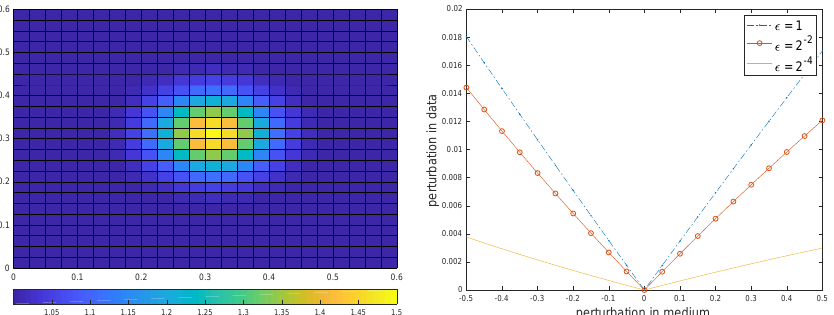
Figure 1. Test 1. ( Left ): ground truth (57) with σ = 0.5. ( Right ): perturbation in measured data versus perturbation in σ